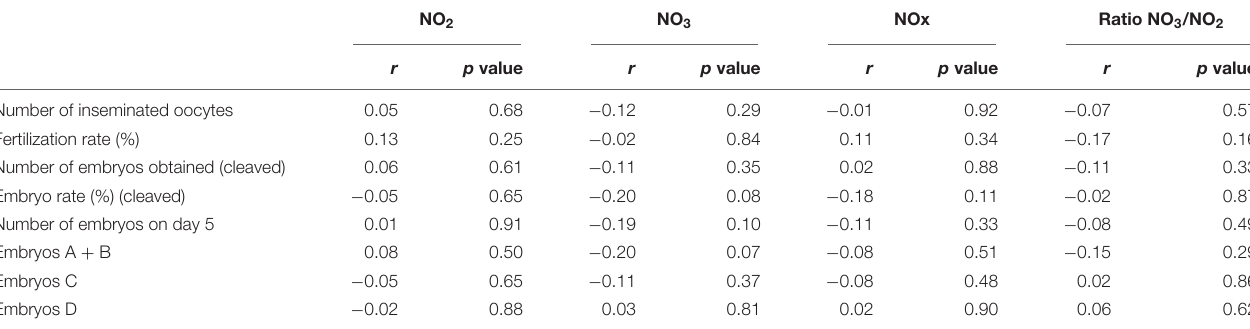
FIGURE 3 | Distribution of grade A and B embryos (maximum and high potential of implantation, respectively) at day 5 of development according to the NO 3 levels in the follicular fluid of healthy women undergoing ovarian stimulation as part of their participation in an oocyte donation program ( n = 75). TABLE 6 | Correlation between NO 2 , NO 3 , NOx, ratio NO 3 /NO 2 , and embryo development and quality of healthy women undergoing ovarian stimulation as part of their participation in an oocyte donation program ( n =